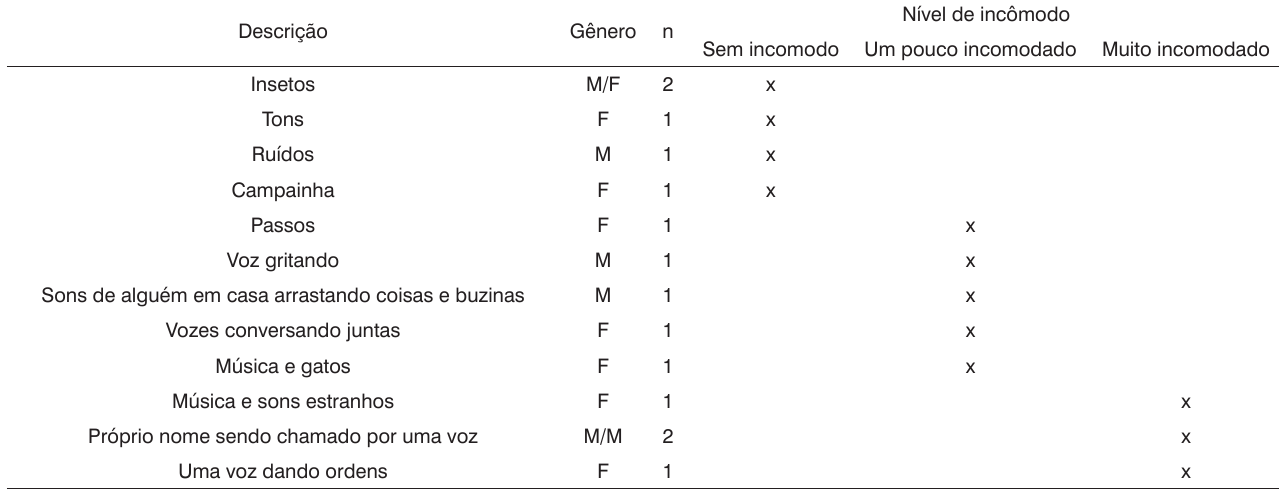
Tabela 3. Número de alucinações auditivas descritas, gênero e nível de incômodo.